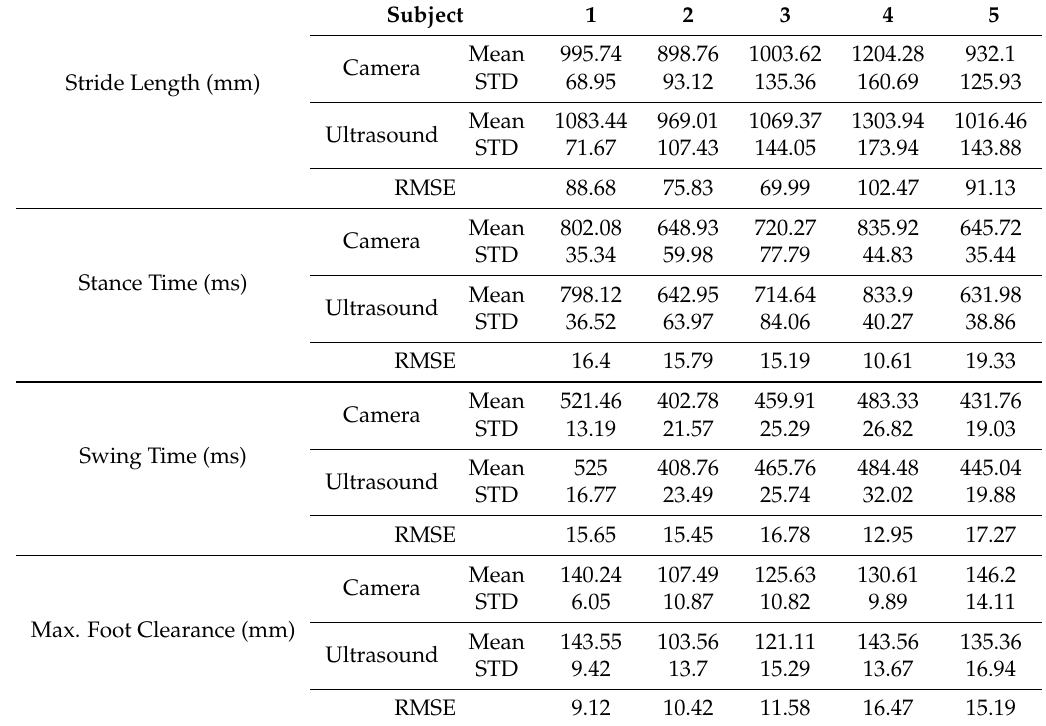
Table 4. Comparison of mean and standard deviation (STD) of gait parameters estimated from the ultrasonic system and the reference camera